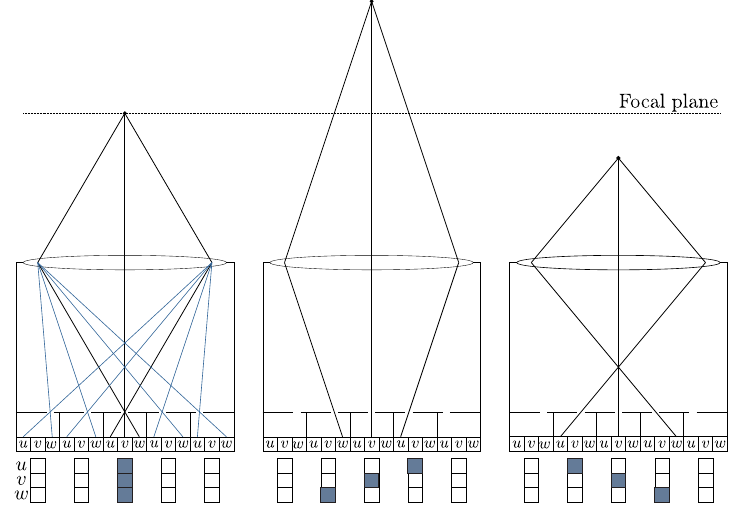
Figure 5. Schematic model of a plenoptic camera with an array of micro lenses (adapted from